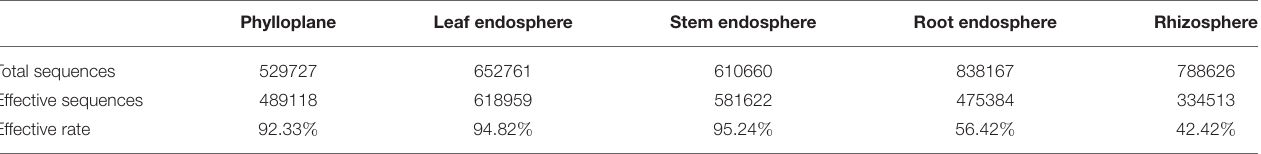
TABLE 1 | Effective sequence number in different ecological